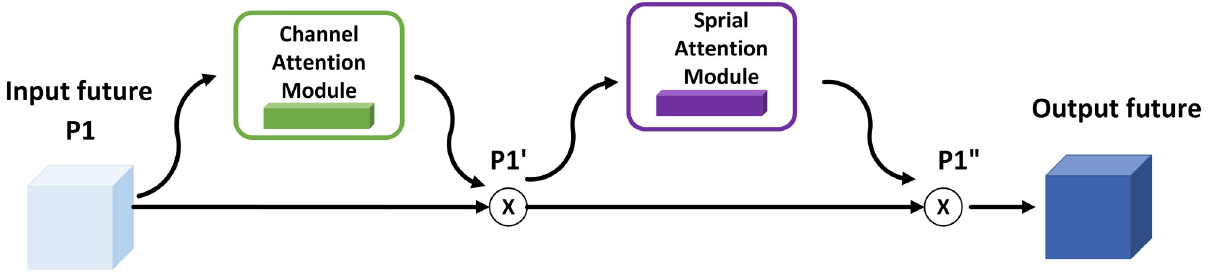
Fig 4. The structural framework of